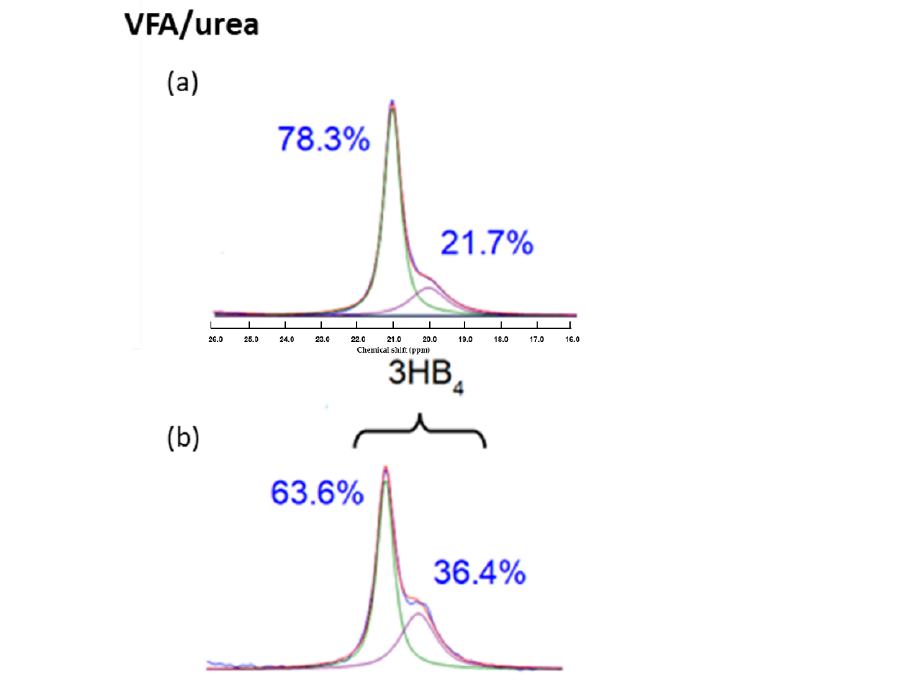
Figure 9. Comparison of the HB methyl peak area of the volatile fatty acid (VFA)/urea sample from ( a ) the CPMAS NMR experiment and ( b ) quantitative direct excitation experiment.